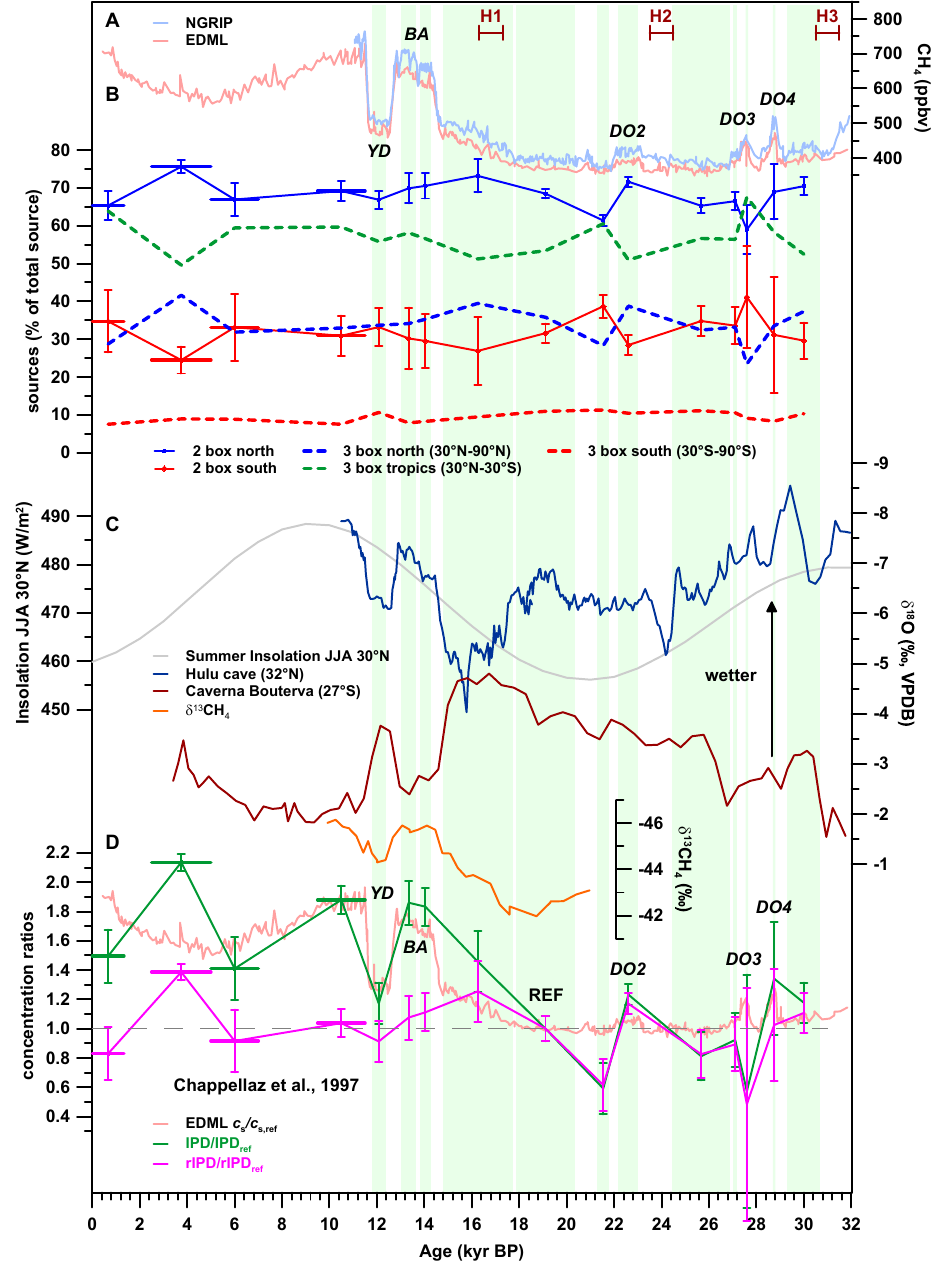
Fig. 7. Variations in the CH 4 source strength. Green shaded areas are the same as in Fig. 1 and indicate the time interval, wherein each point is the mean value of its time interval (Table 1). On the left side, the four Holocene values from Chappellaz et al. (1997) are also included, where the horizontal bars indicate the time interval. (A) CH 4 concentrations from EDML (red, EPICA Community Members, 2006, and new data) and NGRIP (blue, Schilt et al., 2010b, and new data). (B) Source strengths calculated by the two-box and the three-box model as fractions of the total source strength. Solid blue: northern source of two-box model, solid red: southern source of two-box model, dashed blue: northern source (30 ◦ N–90 ◦ N) of three-box model, dashed green: tropical source (30 ◦ S–30 ◦ N) of three-box model, and dashed red: southern source (90 ◦ S–30 ◦ S) of three-box model. (C) Grey: northern summer insolation (30 ◦ N) (Quinn et al., 1991), dark blue: monsoon record from Hulu Cave (Wang et al., 2001), dark red: monsoon record from Caverna Bouterv ´ a (Wang et al., 2007), and orange: δ 13 CH 4 (Fischer et al., 2008). (D) Light red curve in the background: ratio c s /c s , ref (from EDML, (EPICA Community Members, 2006) and new data), green: ratio IPD/IPD ref (Chappellaz et al., 1997, and new data), and pink: ratio rIPD/rIPD ref (Chappellaz et al., 1997, and new data). Interval (V) from Table 1 is used as the reference interval, to put all the ratios on the same scale. With the exception of the monsoon records, which are shown on their original time scales, all data are synchronised to the unified EDML gas age scale derived by Lemieux-Dudon et al.